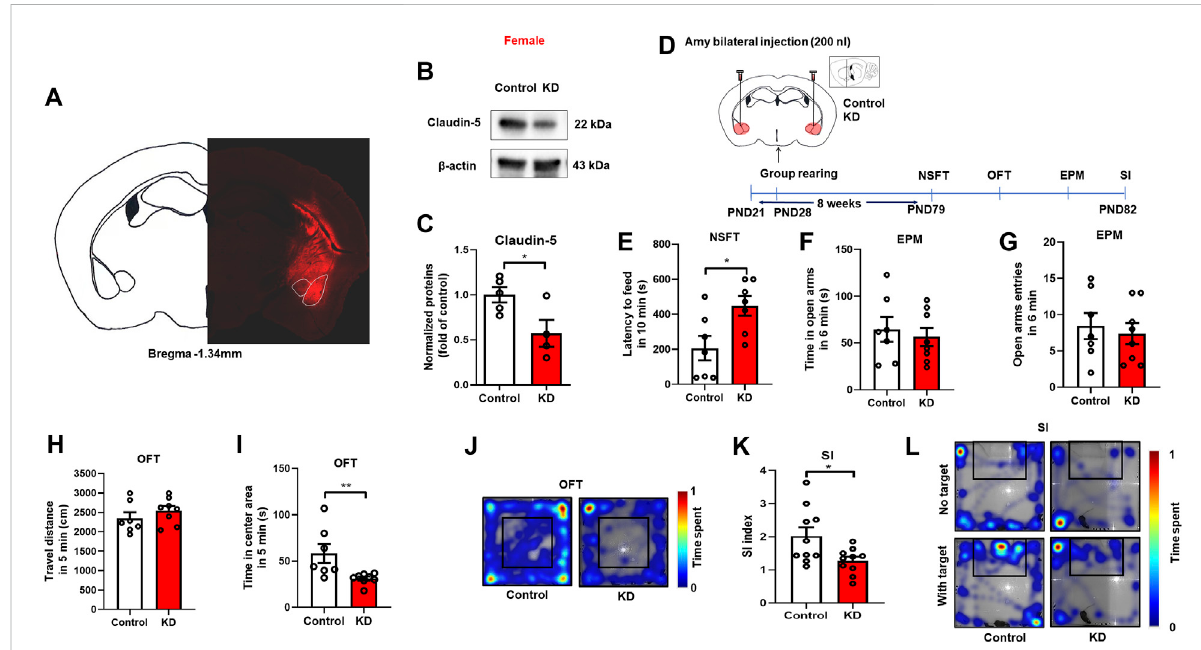
FIGURE 5 Down-regulation of Claudin-5 expression in the amygdala produced anxiety-like behavior in female mice. (A) Representative images of AAV- infected cells in the amygdala of female mouse brain coronal sections (-1.34 mm relative to bregma). Scale bar = 1 mm. (B) Immunoblots of AAV9- CAG-shRNA-mCherry (Control) or AAV-CAG- Cldn5 -shRNA-mCherry (KD) in the amygdala. (C) Quantitative assay of Claudin-5 ( n = 4 – 5). (D) Experimental timeline. (E) The novelty suppressed feeding test. (F,G) The time and entries in open arms in the elevated plus maze test. (H) The locomotor activity in the open fi led test. (I) The time in the center area of open fi eld test. (J) The representative heat maps during the open fi eld test. (K) The social interaction test. (L) The representative heat maps of social interaction test. ( n = 7 – 10). Data were mean ± SEM, * p < 0.05, ** p <